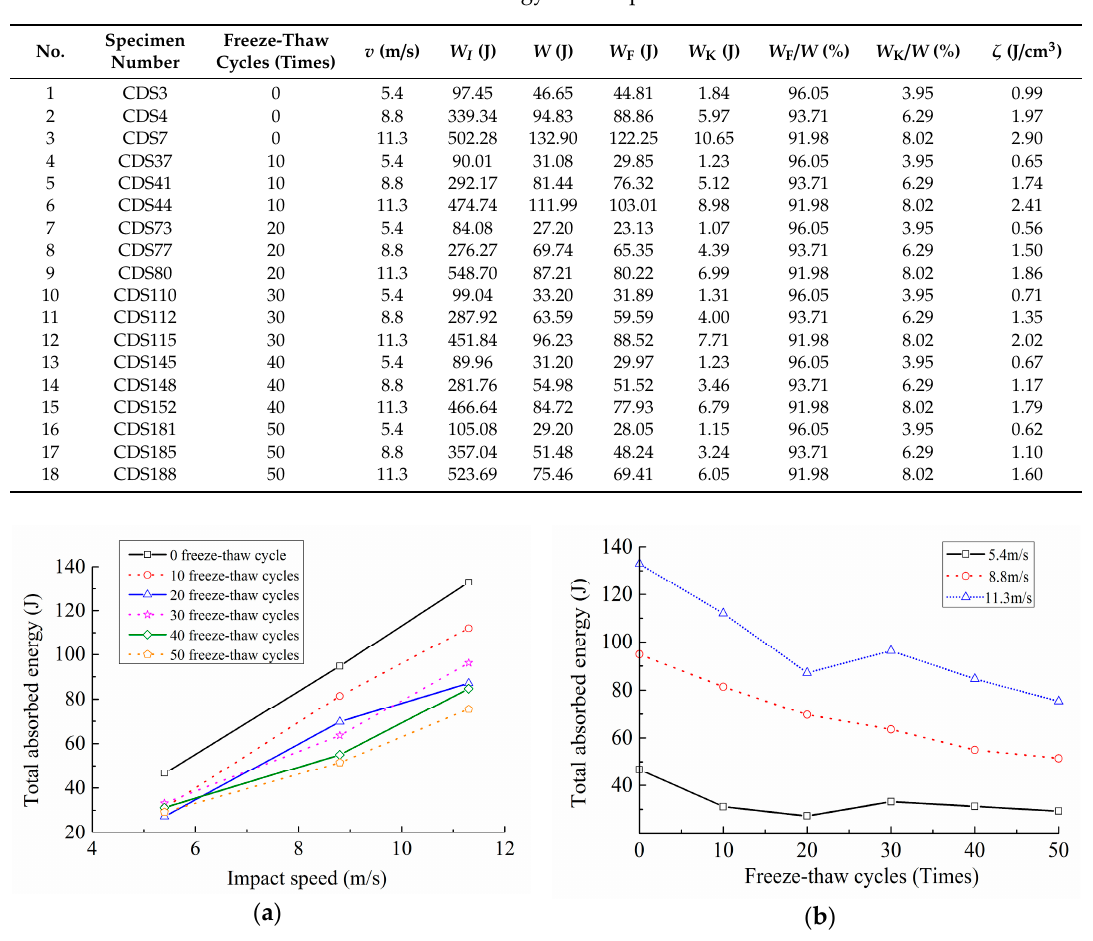
Figure 13. Relation curves of the total absorption energy with freeze-thaw cycles and impact loading speeds. ( a ) Relation curves of the total absorption energy with impact loading speeds; ( b ) Relation curves of the total absorption energy with freeze-thaw